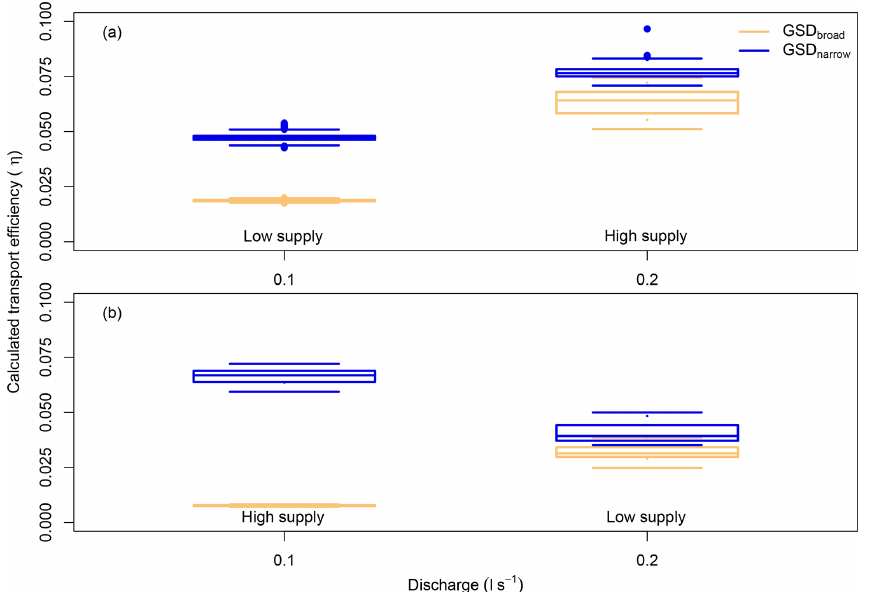
Figure 8. Distribution of transport efficiencies, calculated using Eq. (3). Plots separate experiments by relative sediment concentrations of (a) 1 and (b) not 1 (i.e. 0.5 or 2). Text indicates sediment feed rate (low supply = 1gs − 1 , high supply = 2gs − 1 ).